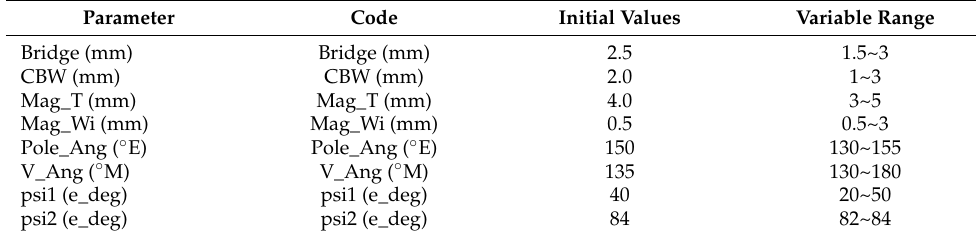
Table 4. Input parameters.